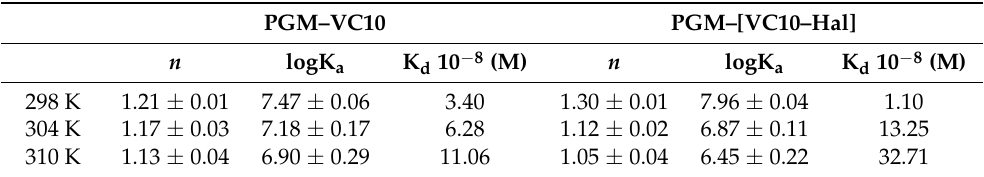
Table 2. Number of binding sites ( n ), binding constants (K a ), and dissociation constants (K d ), for the PGM– VC10 and PGM–[ VC10 – Hal ] systems at different